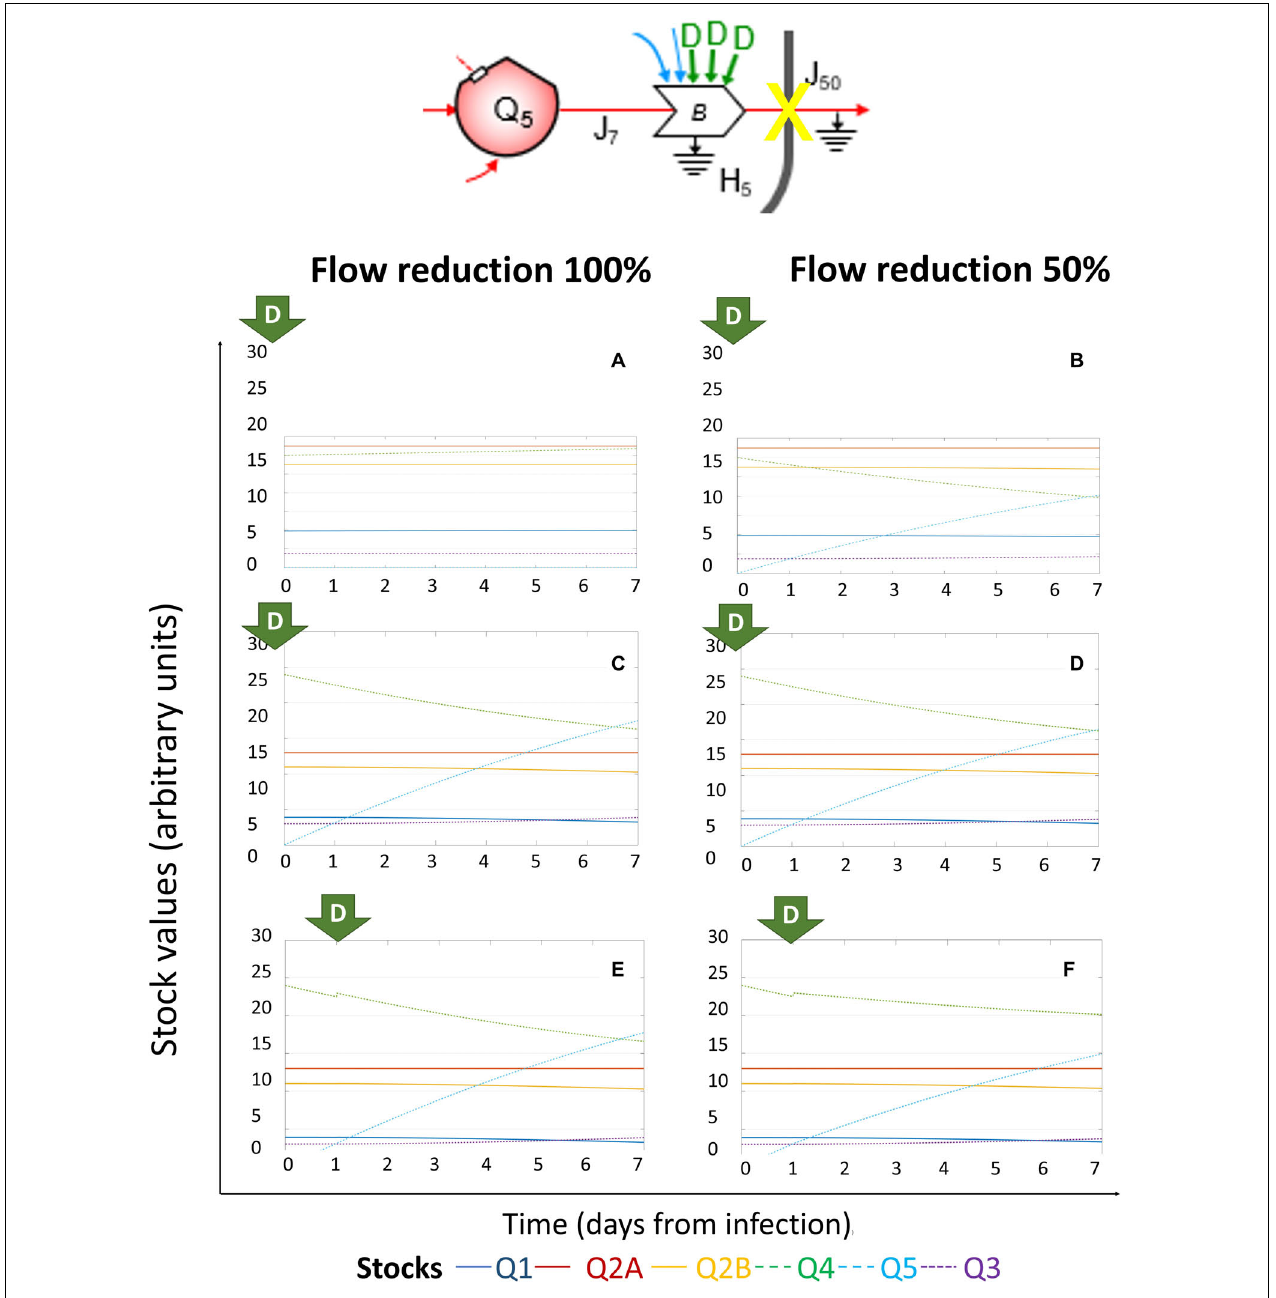
FIGURE 4 | System dynamics of (+)ssRNA virus–host interaction in response to external driving forces applied to reduce virions outflow. Changes over time of the values of each stock of the system diagrammed in Figure 1 (for the color code, see bottom), expressed in ATP-eq, in response to reduction of J 50 (flow of energy required for virions budding). Several scenarios are shown: initial viral load 5k and application of full (100%, A ) or partial (50%, B ) J 50 reduction at Day 0; initial viral load 10k and application of full (100%, C ) or partial (50%, D ) J 50 reduction at Day 0; initial viral load 10k and application of full (100%, E ) or partial (50%, F ) J 50 reduction at Day